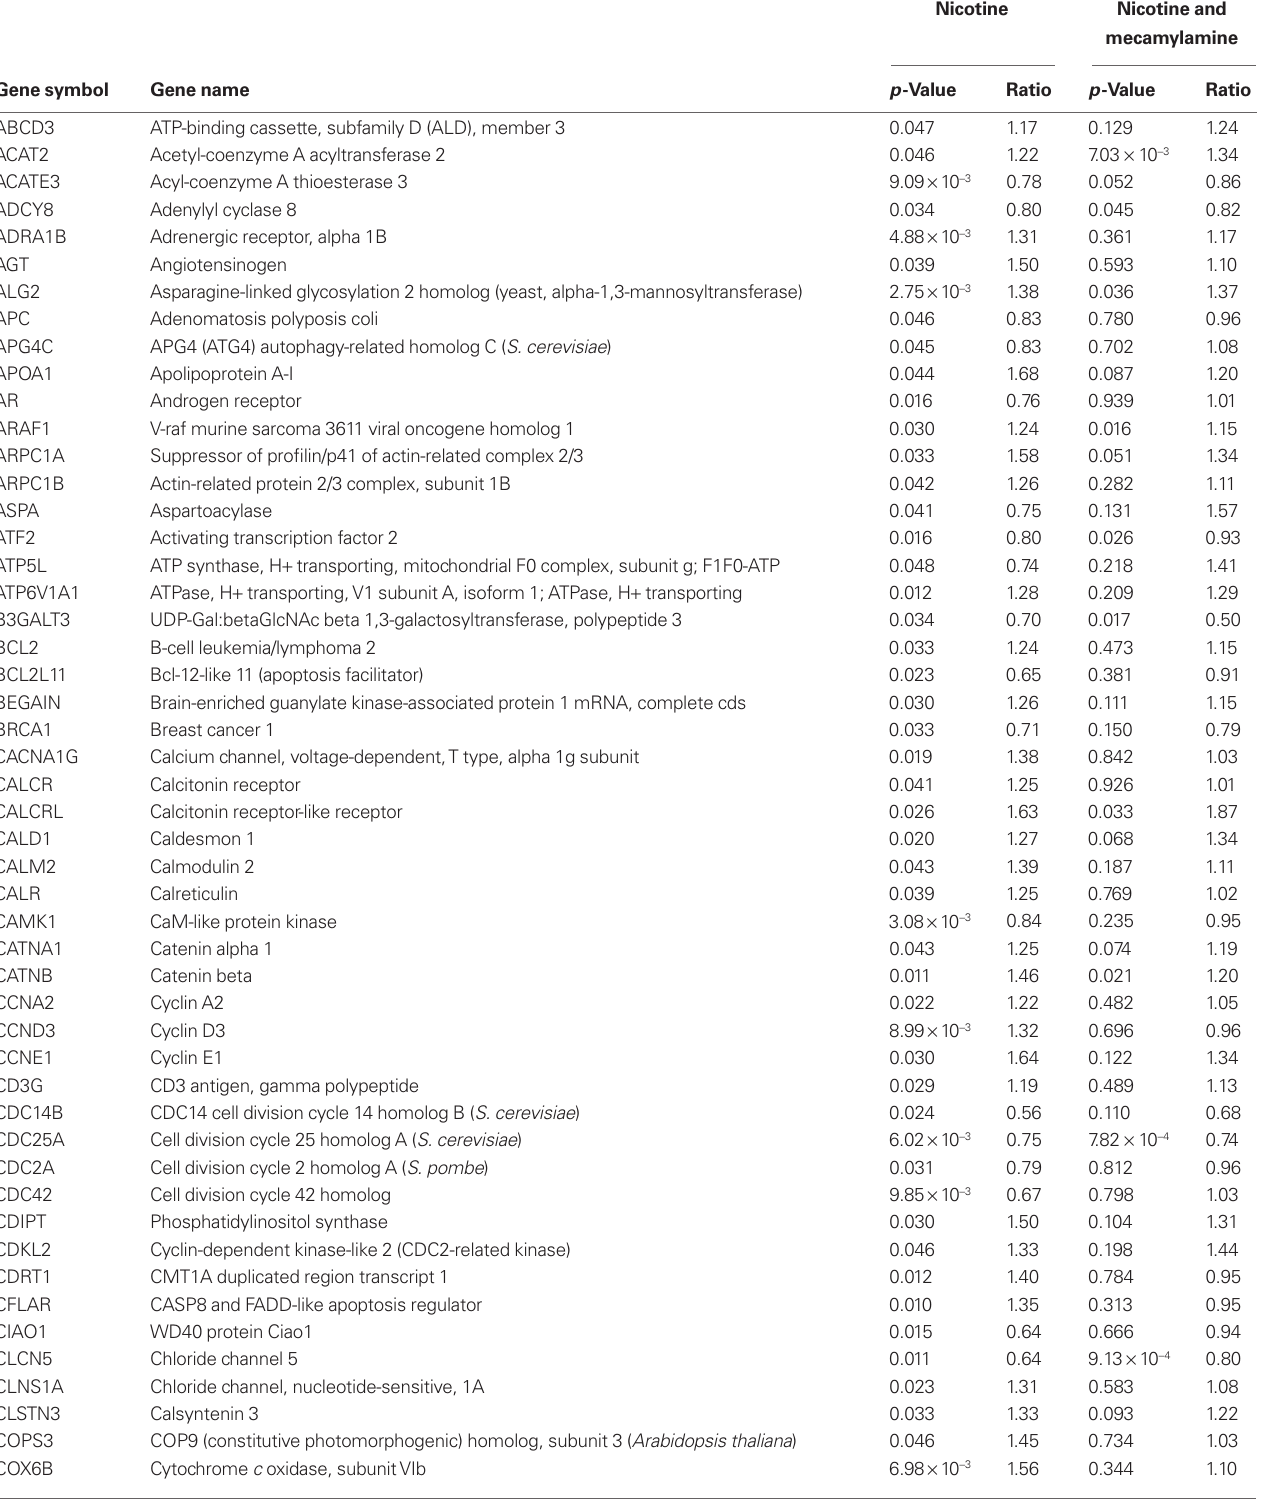
Table A1 | genes significantly expressed in nicotine-treated